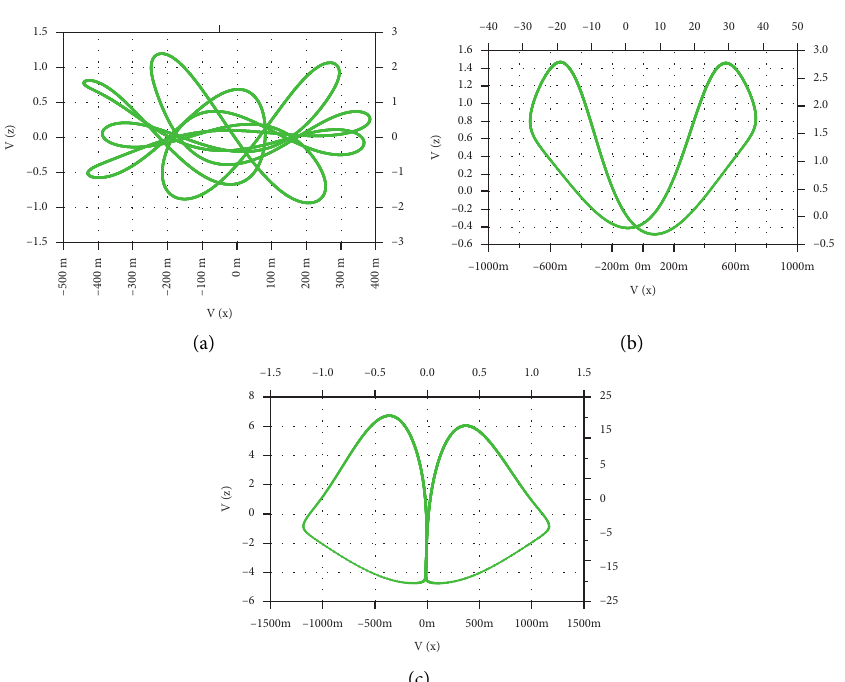
Figure 9: The screenshots of the digital oscilloscope in x − z plane: (a) a �− 6.17; (b) a � − 4.5; (c) a �−